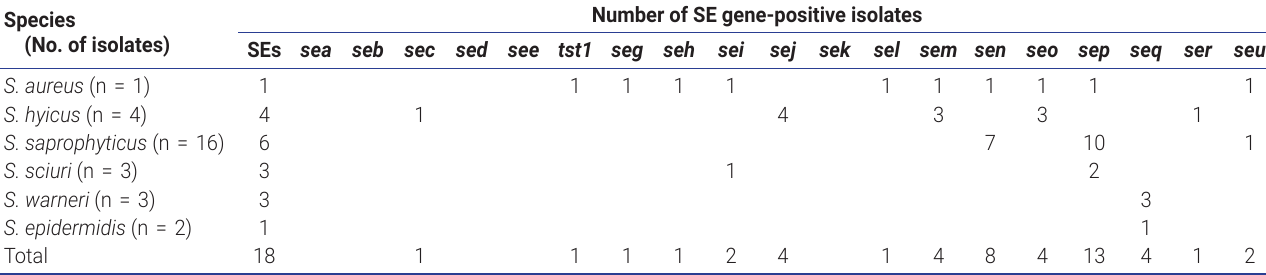
Number of SE gene-positive